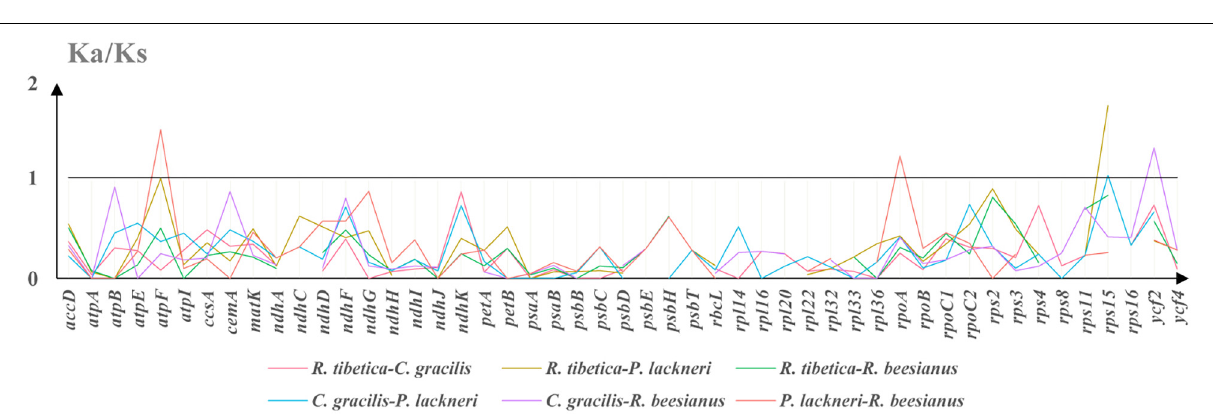
FIGURE 3 | The Ka/Ks ratio of protein-coding genes of four species chloroplast genomes, and Ka/Ks > 1 suggests positive